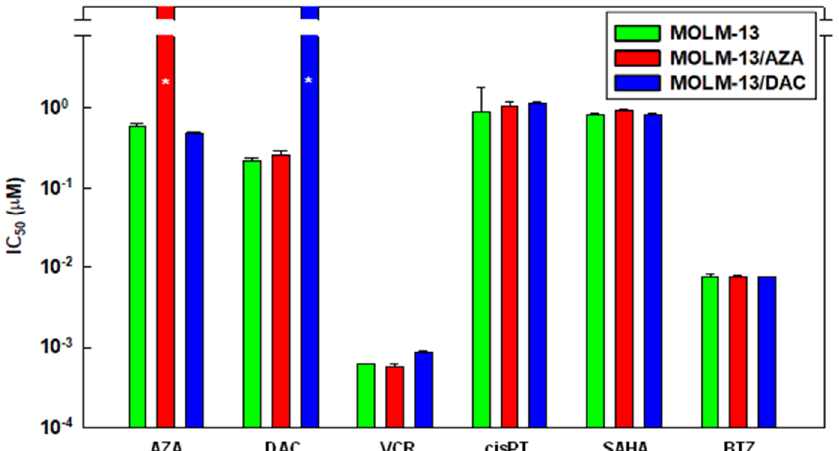
Figure 1. Cell sensitivities to 5-azacytidine (AZA), 5-aza-2′-deoxycytidine (DAC), vincristine (VCR), suberoylanilide hydroxamic acid (SAHA) and bortezomib (BTZ) are expressed as the me- dian inhibitory concentration (IC 50 ). The IC 50 was computed by nonlinear regression according to Equation 1 using SigmaPlot for Windows (Version 8.02, Systat Software GmbH, Erkrath, Ger- many). The data represent computed value ± standard error with 30 degrees of freedom. * = Even at a concentration of 10 μM, neither AZA nor DAC showed a half-maximal inhibitory effect on the cells.